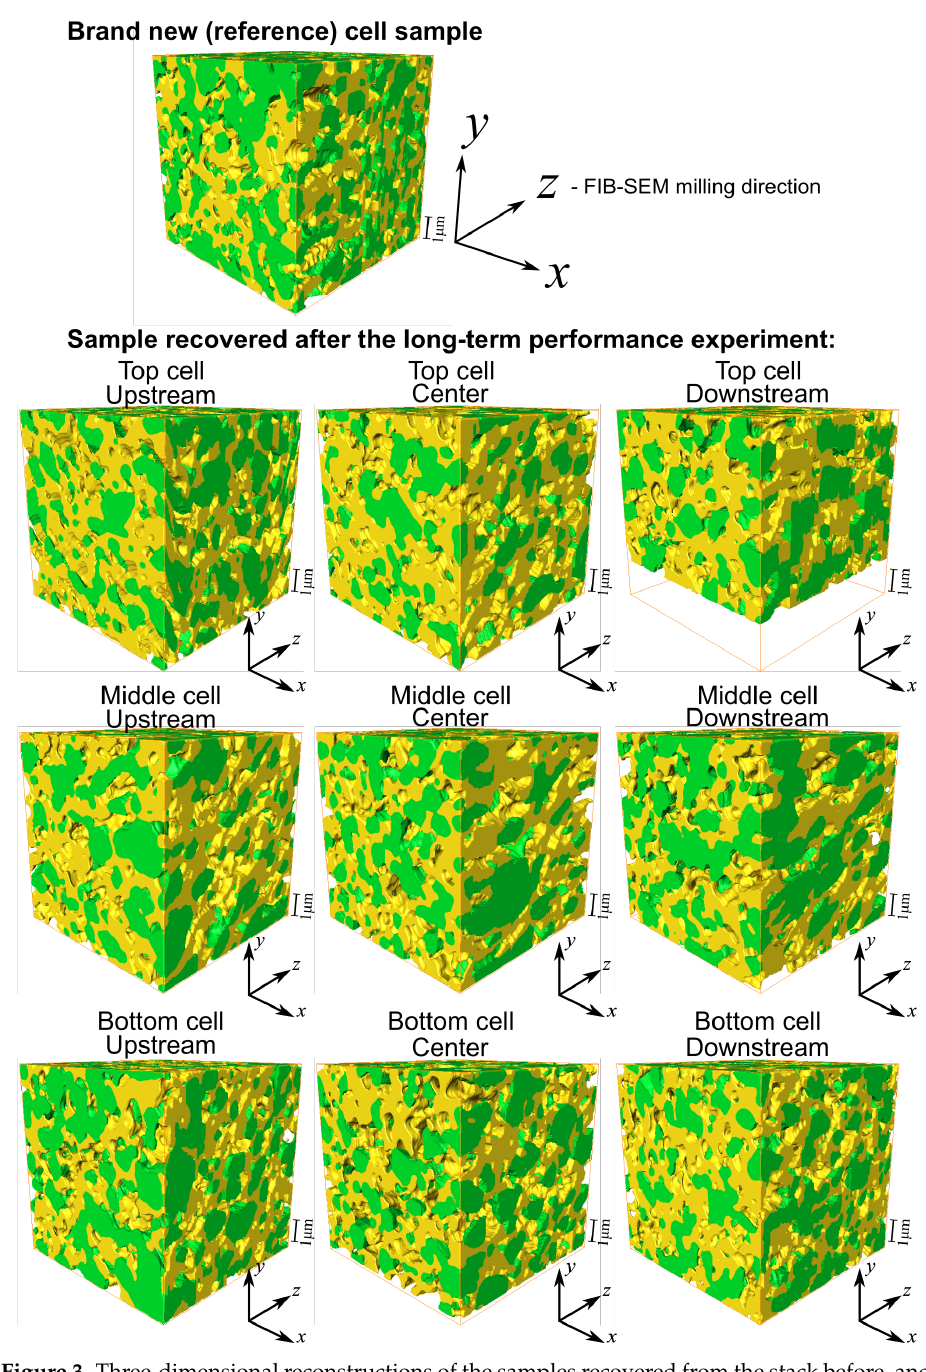
Figure 3. Three-dimensional reconstructions of the samples recovered from the stack before, and after the degradation